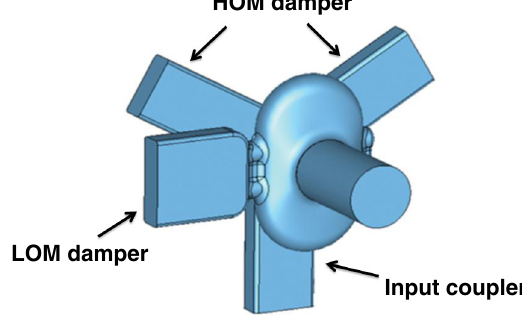
FIG. 1. The APS deflecting cavity geometry with an on-cell damper and an Y-end group on the beam